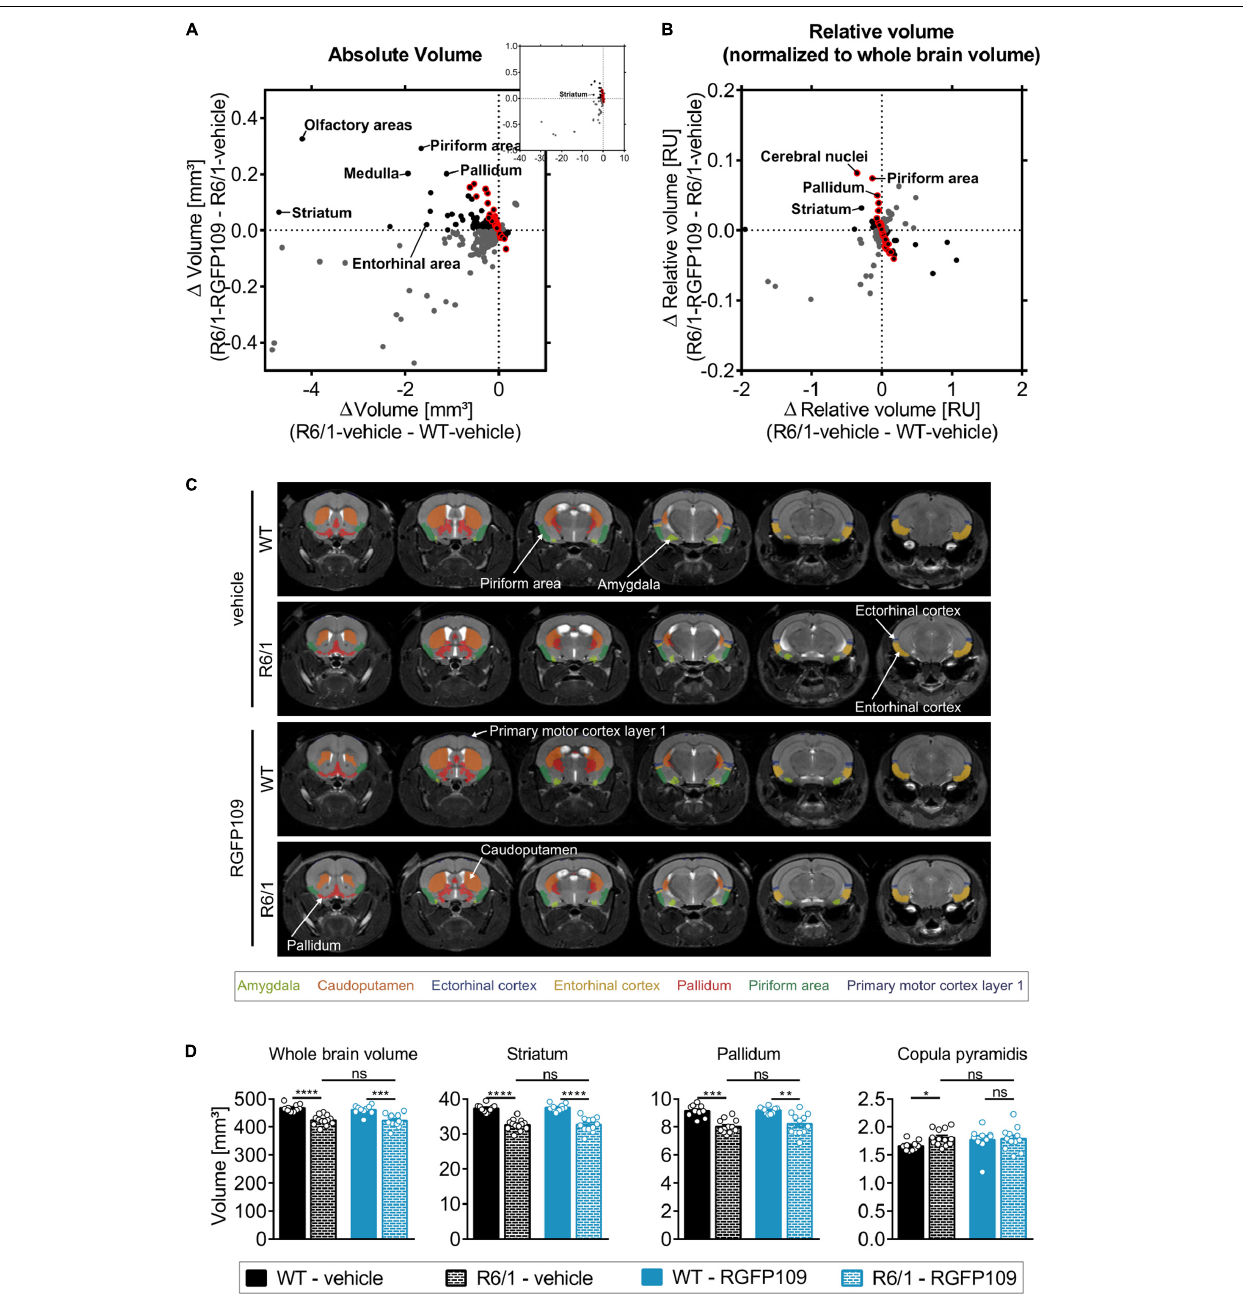
FIGURE 3 | Effect of RGFP109 treatment on HD-associated atrophic brain substructures in R6/1 mice. Mouse brain MR images were registered to the Allen brain atlas. Volumes of substructures (absolute or normalized to whole brain volumes) were analyzed by two-sample t -test (FDR, q < 0.1). (A) Mean absolute volume differences of brain regions with significant volume change in R6/1 compared to WT mice (419). (B) Mean relative volume differences of brain regions with significant volume change in R6/1 compared to WT mice (220). (A,B) Black: substructures affected positively by drug (not significant; red frame: > 20% of R6/1-WT volume difference); Gray: substructures affected negatively by drug (not significant). (C) MR images, exemplarity shown for three individuals; selected regions are color-coded. Anatomical labels are based on the Allen brain atlas. (D) Absolute volumes of selected brain regions. Data presented as mean ± SEM; n = 10 [WT-vehicle], n = 13 [R6/1-vehicle], n = 10 [WT-RGFP109], n = 12 [R6/1-RGFP109]; * q < 0.05, ** q < 0.01, *** q < 0.001, **** q < 0.0001, ns, not